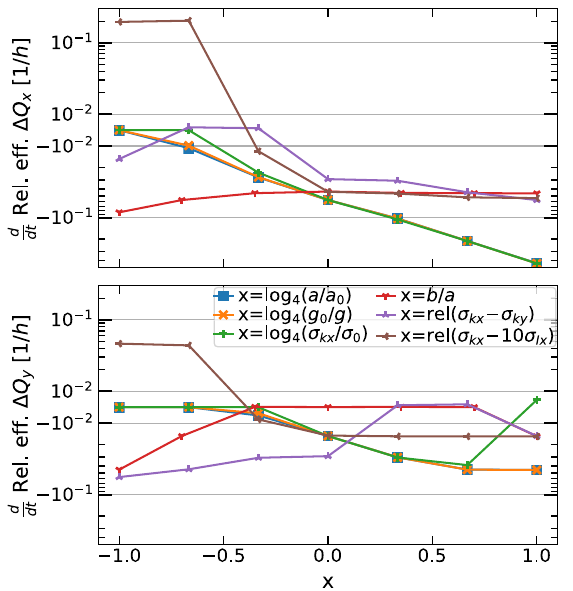
FIG. 9. The initial reduction of the relative effective detuning strength, from the scans that are given in more detail in Fig. 8. The value corresponds to the change during the first hour, after starting with a Gaussian transverse distribution. The vertical scale is linear on the interval ½ − 10 − 2 ; 10 − 2 (cid:2) , and logarithmic